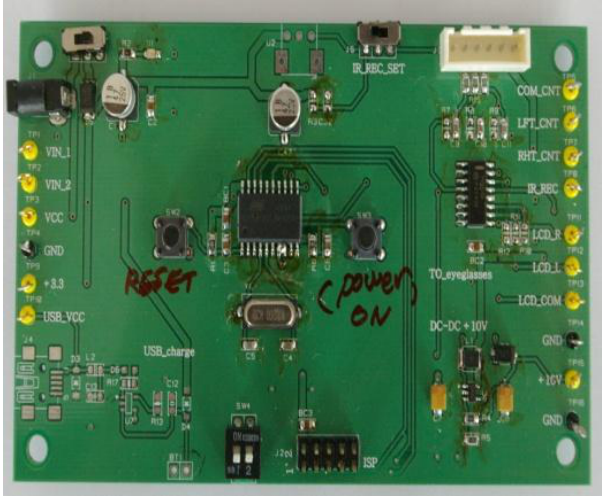
Figure 7. Test board of the reception module for the active shutter glasses with the flexible liquid crystal